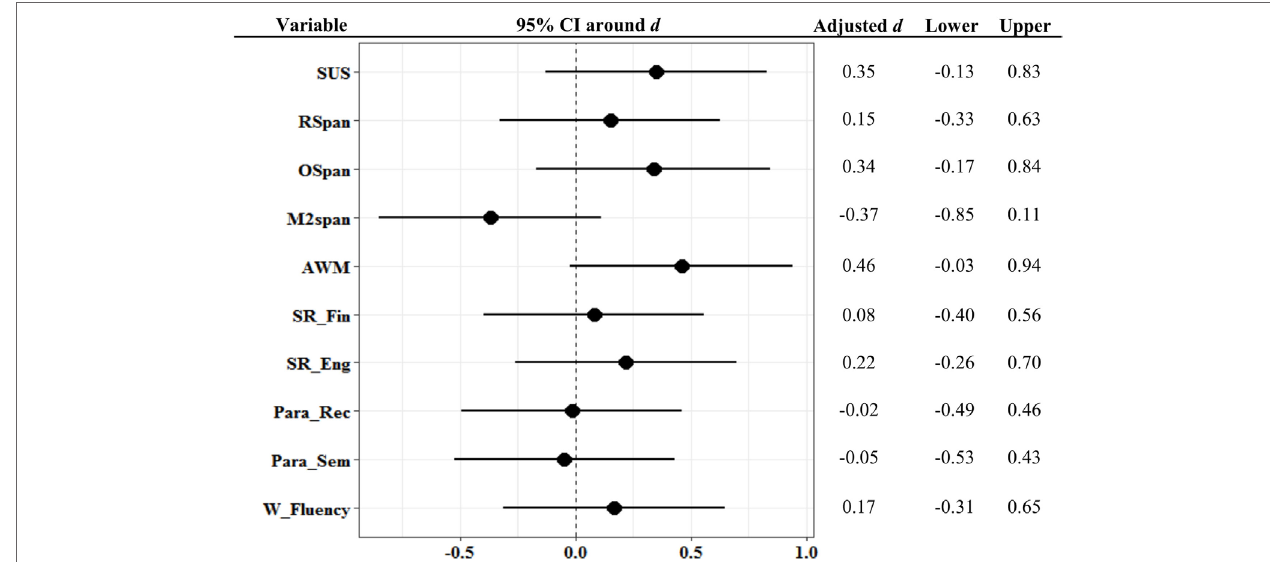
FigUre 7 | Forest plot of the training outcome with 95% confidence intervals represented by horizontal lines, from the group comparisons of training effects in the present study. Higher effect sizes indicate better performance in the WM training group. Cohen’s d is computed from estimated posttest measurement scores adjusted for pre-measurements in the ANCOVA. ANCOVA, analysis of covariance; AWM, Alphabet working memory task; M2Span, Minus 2 span; OSpan, Operation span; Para_Rec, Paragraph recall; Para_Sem, Paragraph semantic recall; RSpan, Reading span; SR_Eng, Sentence recall in English; SR_Fin, Sentence recall in Finnish; SUS, selective updating of sentences; W_fluency, Word fluency; WM, working